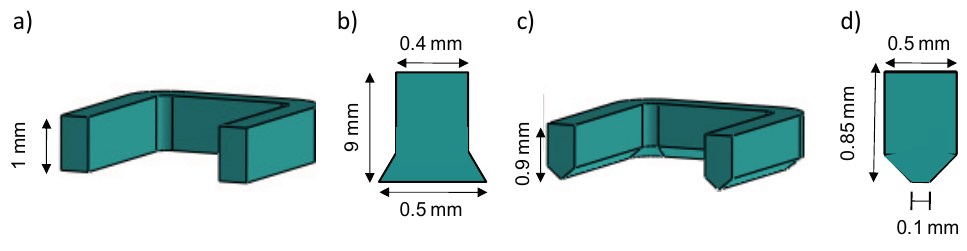
Figure 5. Schematics of the tested PDMS central seals. ( a ) Cross-sectional view of the first tested rectangular seal with a flat end; ( b ) 2D view of one of the flat end seal’s walls pressed onto the sensor surface; ( c ) Cross sectional view of the rectangular seal with a peak